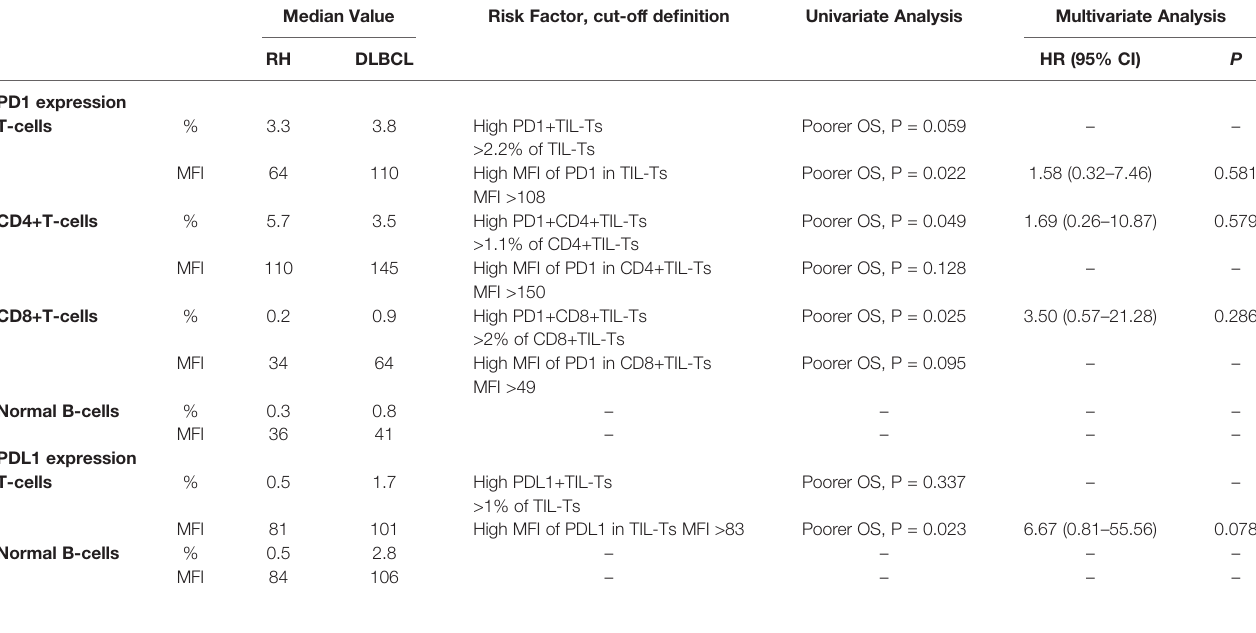
TABLE 2 | Univariate and multivariate survival analyses of PD1/PDL1 expression in tumor-in fi ltrating lymphocytes (TILs) of diffuse large B-cell lymphoma (DLBCL) evaluated by fl ow cytometry within each cell type. Median Value Risk Factor, cut-off de fi nition Univariate Analysis Multivariate Analysis RH DLBCL HR (95% CI)